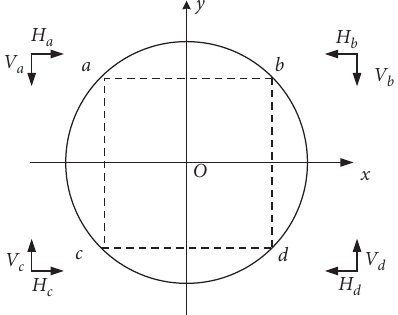
Figure 4: Relation diagram of gradient directions of symmetrical points on a circle.